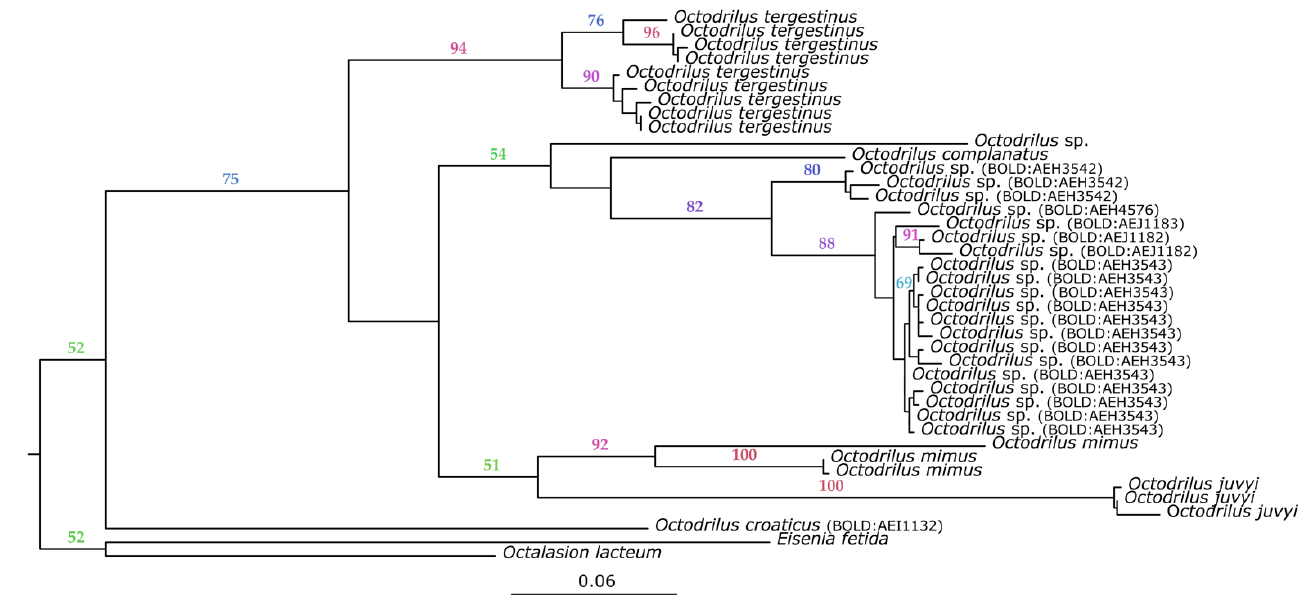
Figure 4. Maximum likelihood phylogram inferred for specimens of the genus Octodrilus . Numbers on the branches represent the nonparametric bootstrap support (  50). The tree is rooted on Octo- lasion lacteum (BOLD:ACF5848) and Eisenia fetida (BOLD:AAB2558) as